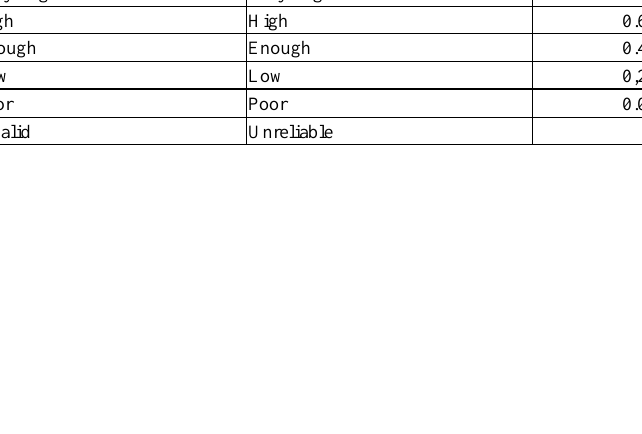
Table 1. Guilford Classification for Validity and Reliability Scores of Evaluation Instruments Validity